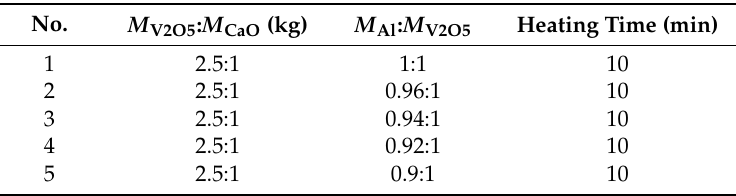
Table 2. The composition of raw materials.